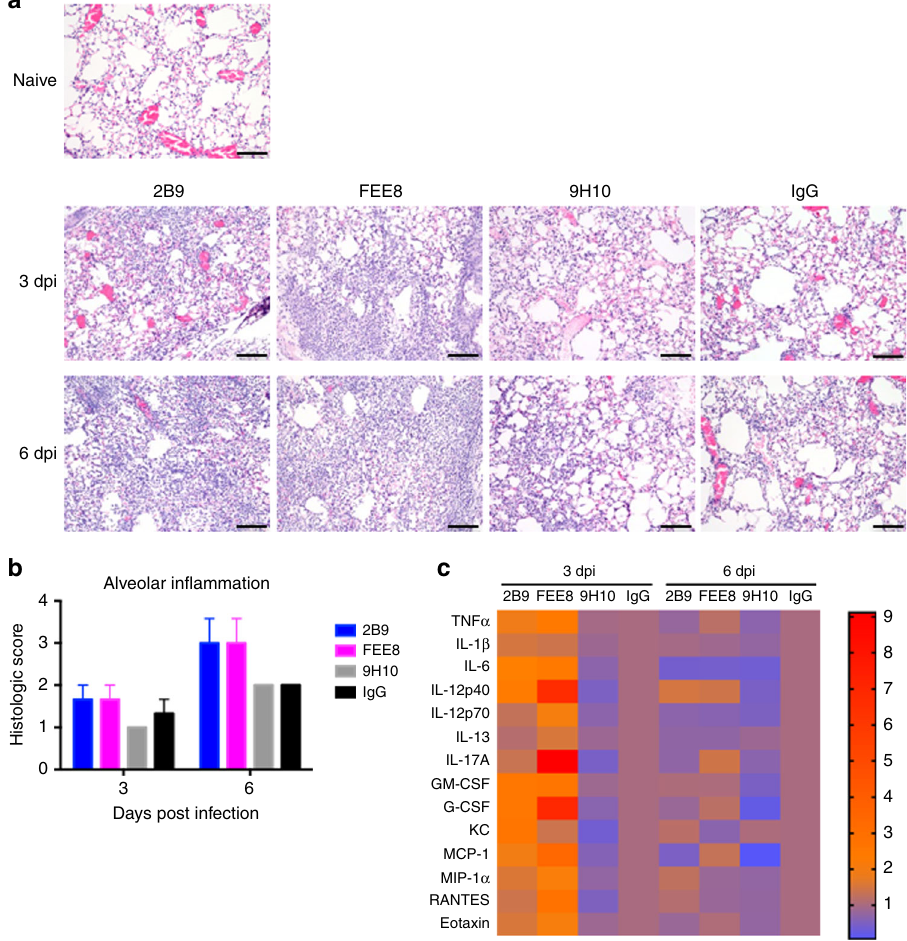
Fig. 2 Mice administered with nonNAbs have higher alveolar in fl ammatory responses upon IAV infection. Groups of BALB/c mice ( n = 3) were administered IP with indicated mAbs (15 mg per kg) and challenged IN with 5 mLD 50 of X31. a At 3 and 6 dpi, lung sections from naive, 2B9, FEE8, 9H10, or IgG-treated animals ( n = 3 mice per group) were stained with hematoxylin and eosin. Scale bar , 100 µ m. Control IgG is a murine mAb that targets GST. b Independent pathology quanti fi cation of alveolar in fl ammation is as indicated. Error bars represent standard error mean (SEM). c BALF were also collected from animals and analyzed for cytokine/chemokine production. A heat map was generated using GraphPad Prism. Heat map represents fold changes of cytokine/chemokine protein levels in BALF from the indicated treatments. Values are normalized to corresponding IgG